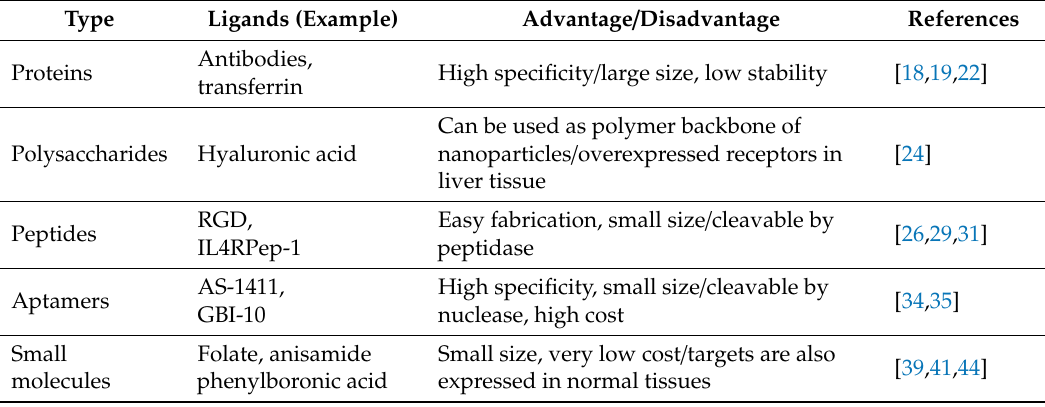
Table 1. Ligands for active targeting of nanoparticle drug delivery